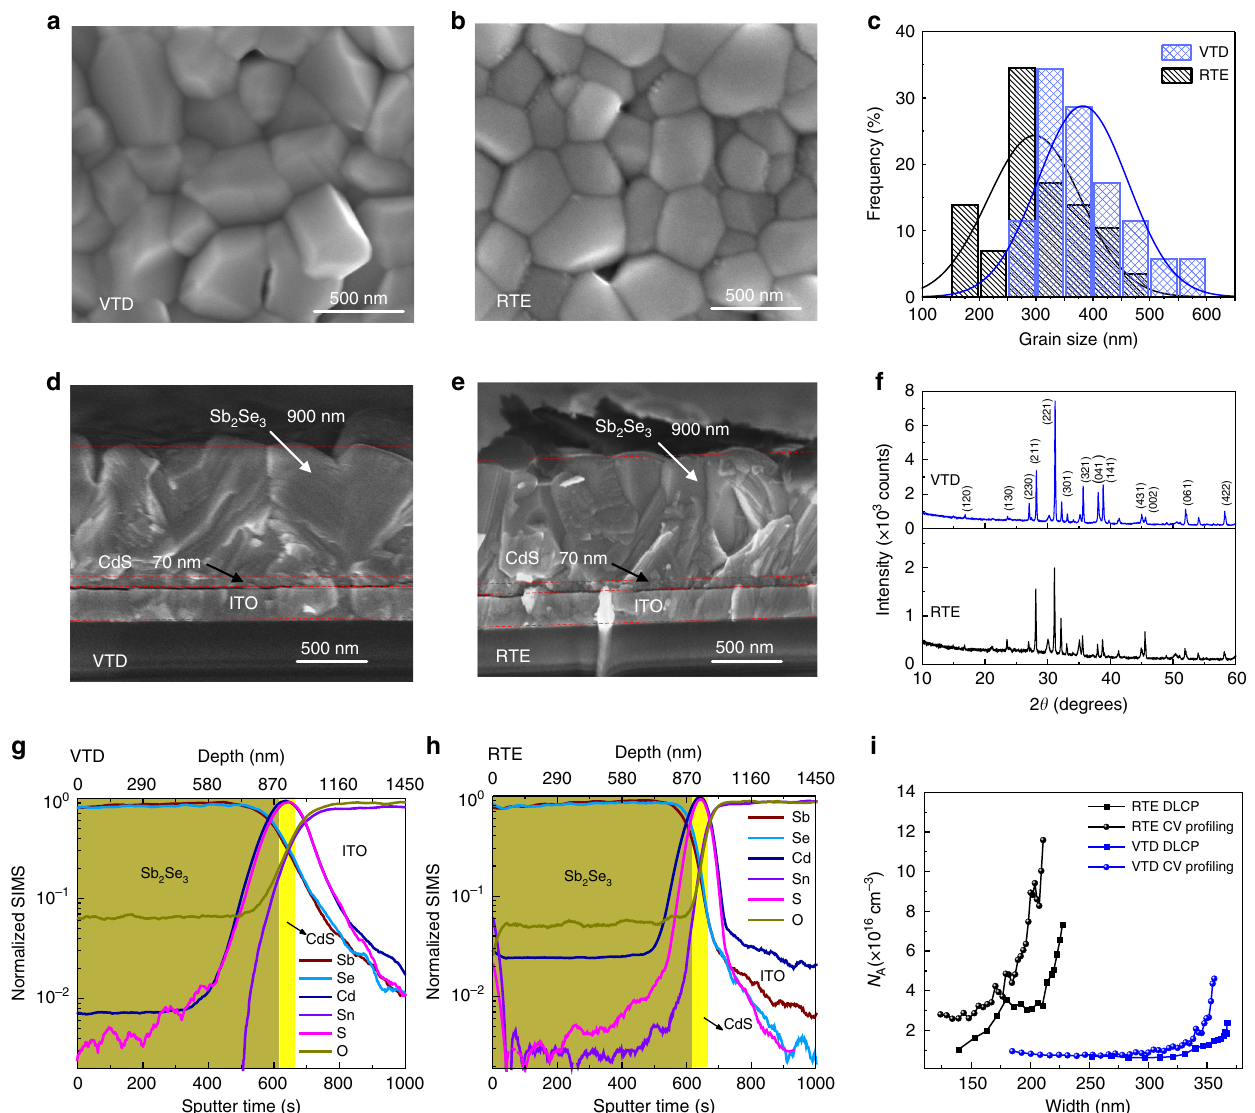
Fig. 4 Characterization of Sb 2 Se 3 fi lms and interface analysis of CdS/Sb 2 Se 3 devices. SEM top-view images of a VTD-fabricated and b RTE-fabricated Sb 2 Se 3 fi lms. c Histogram of grain size in VTD-fabricated and RTE-fabricated Sb 2 Se 3 fi lms. Cross-sectional SEM images of d VTD-fabricated and e RTE- fabricated CdS/Sb 2 Se 3 devices. f XRD of VTD-fabricated and RTE-fabricated Sb 2 Se 3 fi lms. SIMS depth analysis of g VTD-fabricated and h